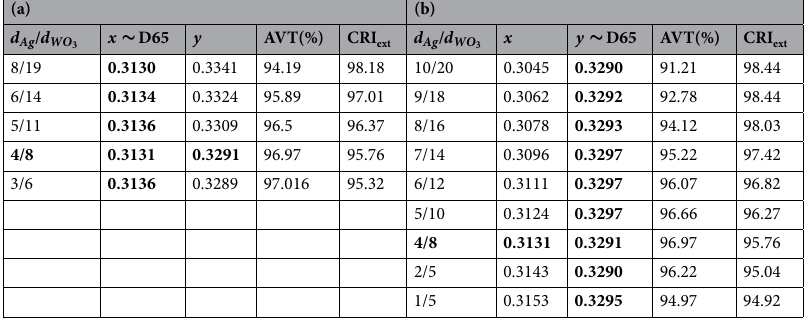
Table 2. Optical parameters of transparent contact structure with colour over D65. Optical parameters of the structures corresponding to the exact values of d Ag and d WO 3 in the case that (a) CIE x and, (b) y coordinates are at D65. Significant values are in [bold].